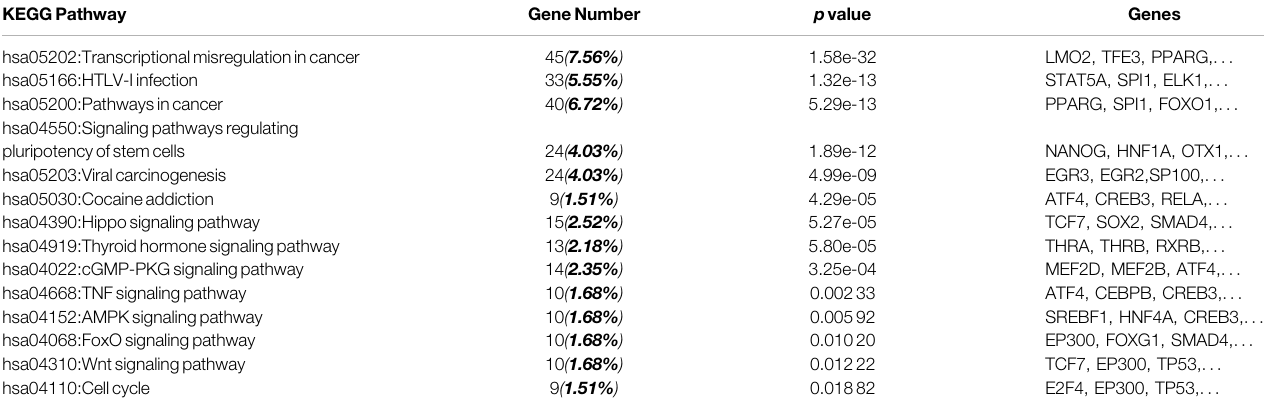
TABLE 4 | KEGGPathwayanalysisoncriticalgenes.